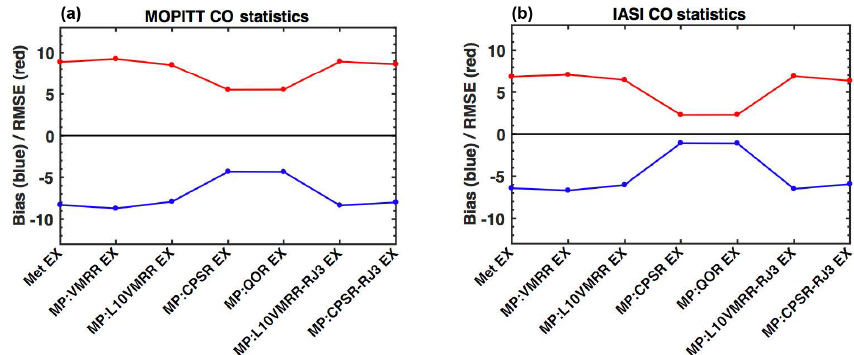
Figure 1. Forecast (assimilation prior) verification statistics for all experiments in MOPITT retrieval space on the left and IASI retrieval space on the right. The red curve is root mean square error (RMSE), and the blue curve is bias (model – observation). The experiments are described in the text and summarized in Table